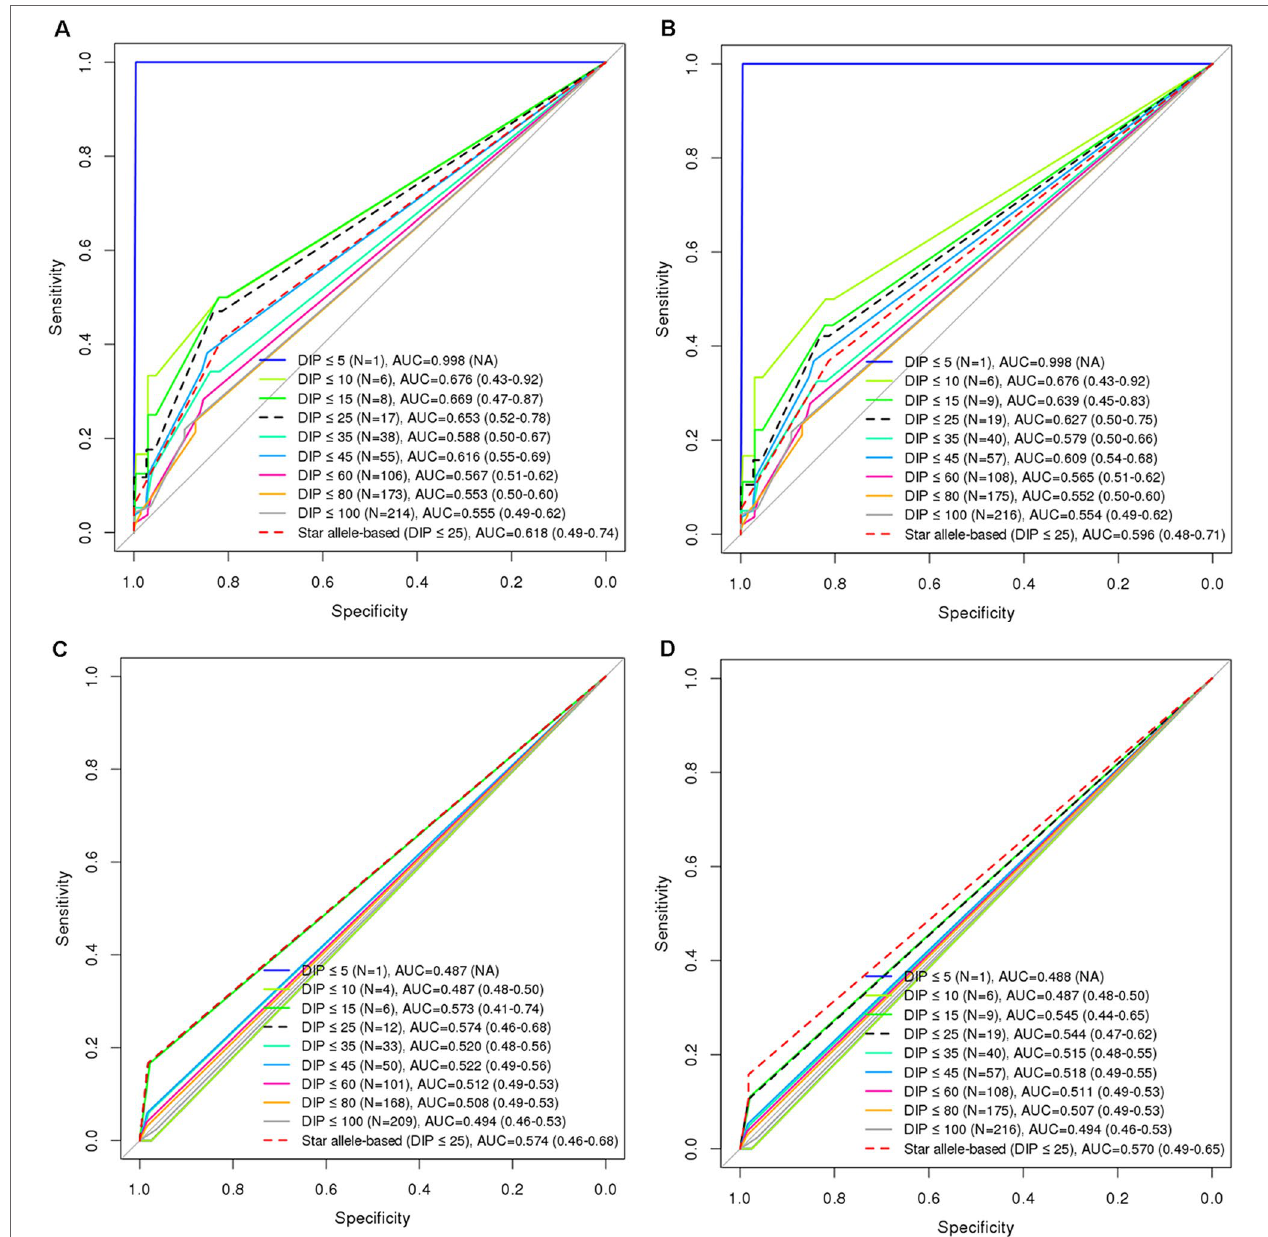
FIGURE 4 | Comparison of diagnostic accuracies between star allele-based molecular phenotyping and GVB scoring for 6-mercaptopurine intolerance in ALL. Diagnostic accuracies are measured by using AUROC analysis for (A) GVB NUDT15 excluding two subjects with TPMT variants (DeLong’s p -value = 0.163), (B) GVB NUDT15 (DeLong’s p -value = 0.163), (C) GVB TPMT excluding seven subjects with NUDT15 variants (DeLong’s p -value = 0.5), and (D) GVB TPMT (DeLong’s p -value = 0.841). Numbers in the last parentheses indicate area under the curve (AUC) with 95% confidence intervals. DIP, dose intensity percent; AUC, area under the